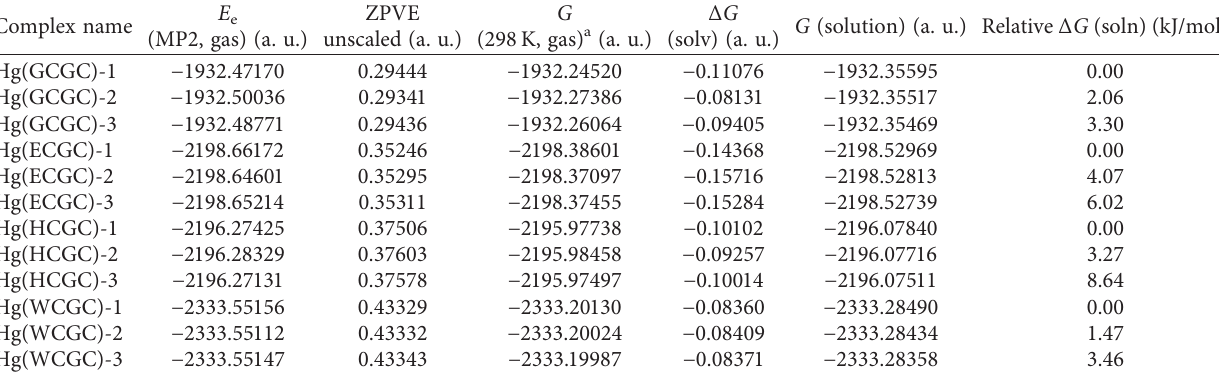
soln and relative Gibbs energy in solution for each complex.